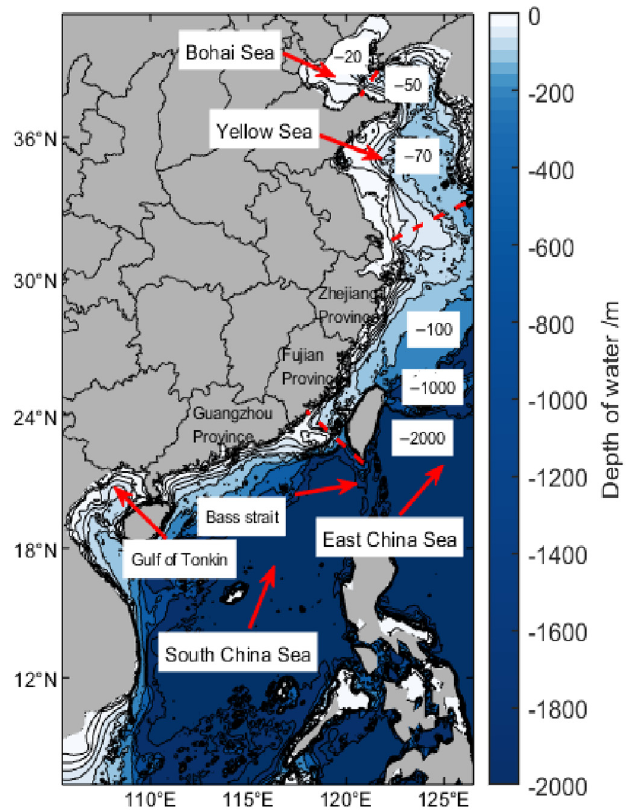
Figure 1. The research area and the